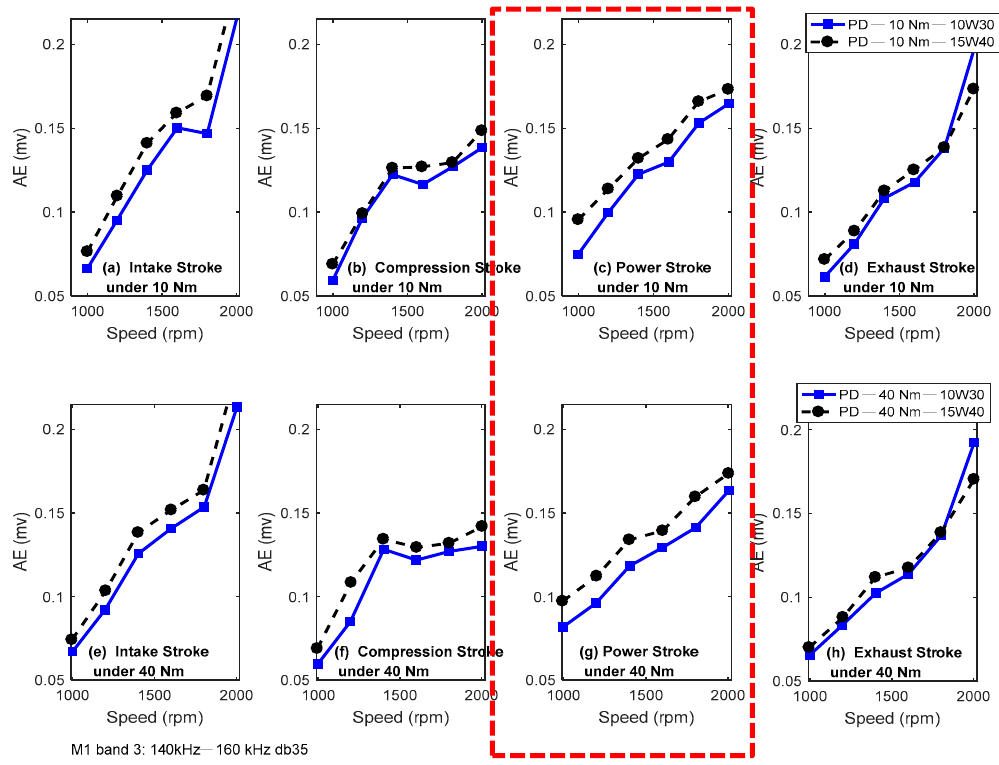
Figure 9. AE indicators from 140 kHz to 160 kHz for four strokes under different operating conditions.